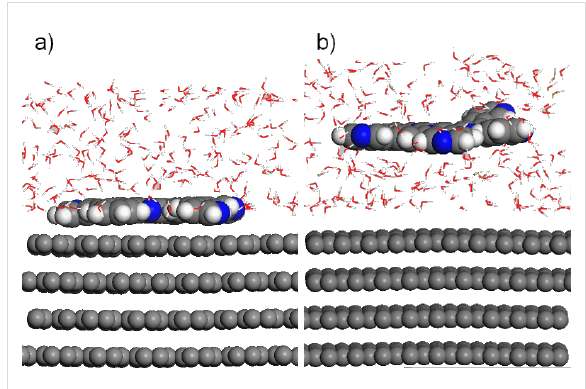
Figure 2: Structural models used to derive the free enthalpy of adsorp- tion of a dissolved molecule: (a) adsorbed molecule at the substrate/ solvent interface and (b) dissolved molecule above the substrate/ solvent interface.